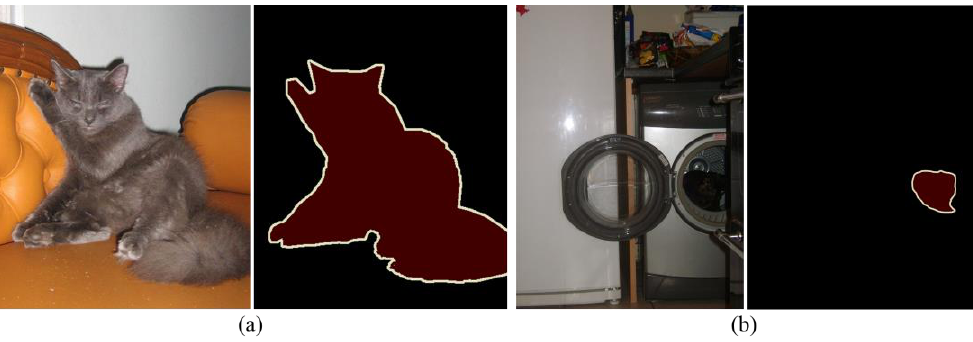
Figure 2. The difference between generic object and camouflaged object. ( a ) Generic object; ( b ) Camouflaged object.